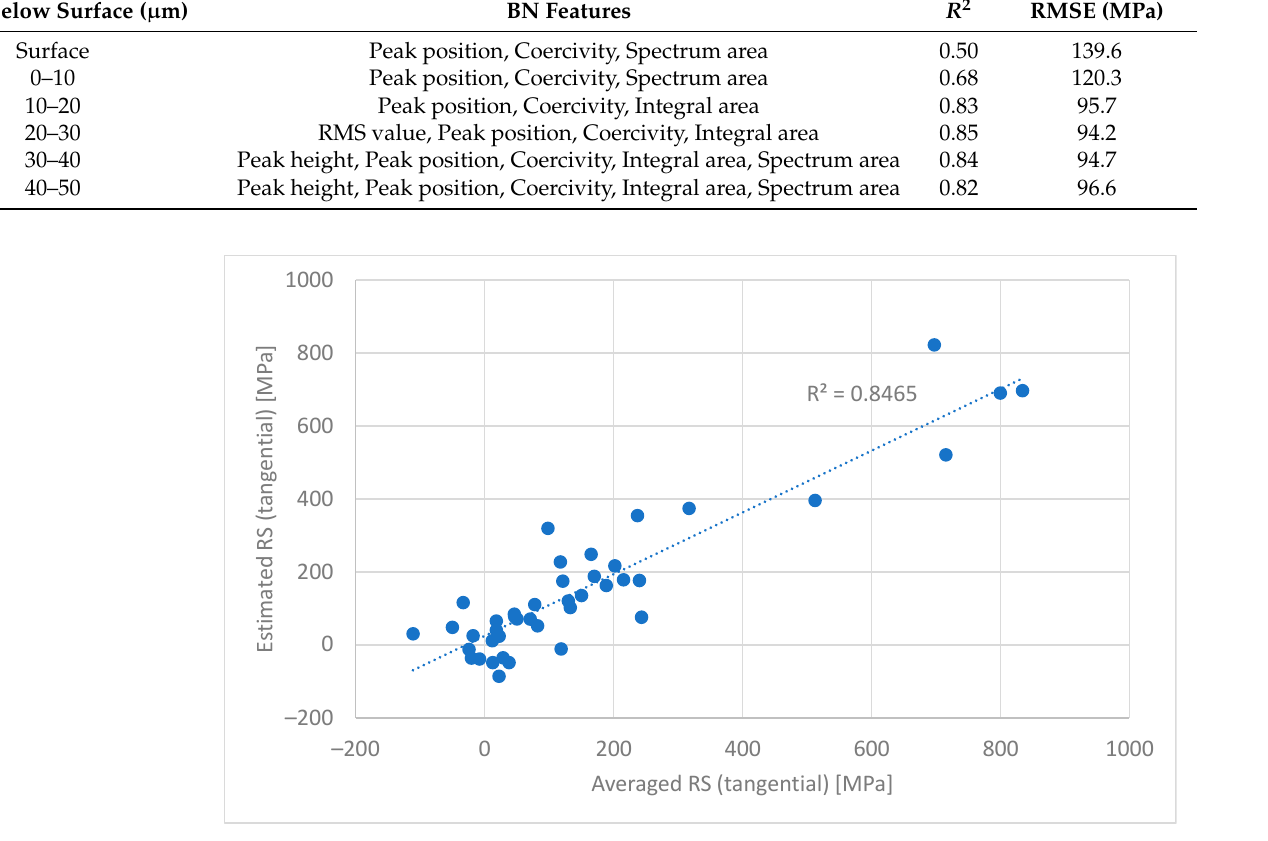
Figure 7. Scatter plot of estimated vs. measured RS for the model with the best performance (20–30 µm). The BN features in this model were the RMS value, peak position, coercivity and integral area.